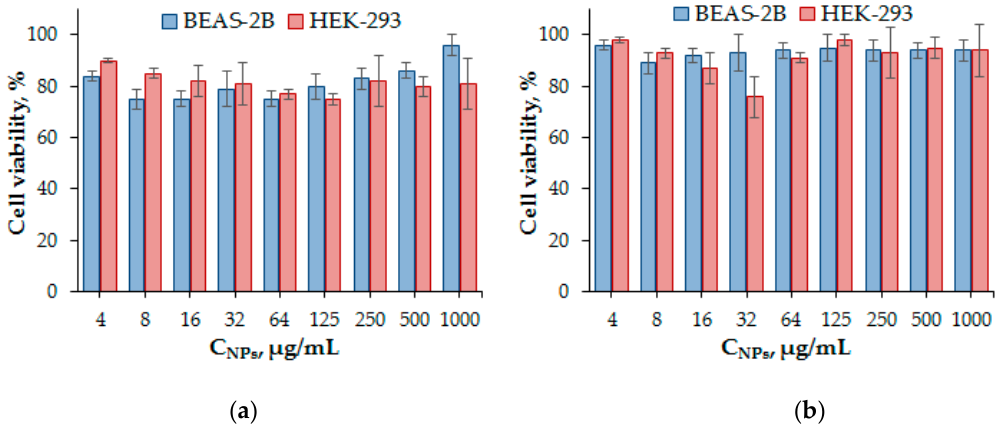
Figure 11. Viability of human embryonic kidney (HEK 293) and human lung cells (BEAS-2B) after their incubation for 3 days in the presence of PMAG- b -PGlu(OBzl) micelles (sample b5 ) ( a ) and PMAG- b -PIle polymersomes (sample b7 ) ( b ).